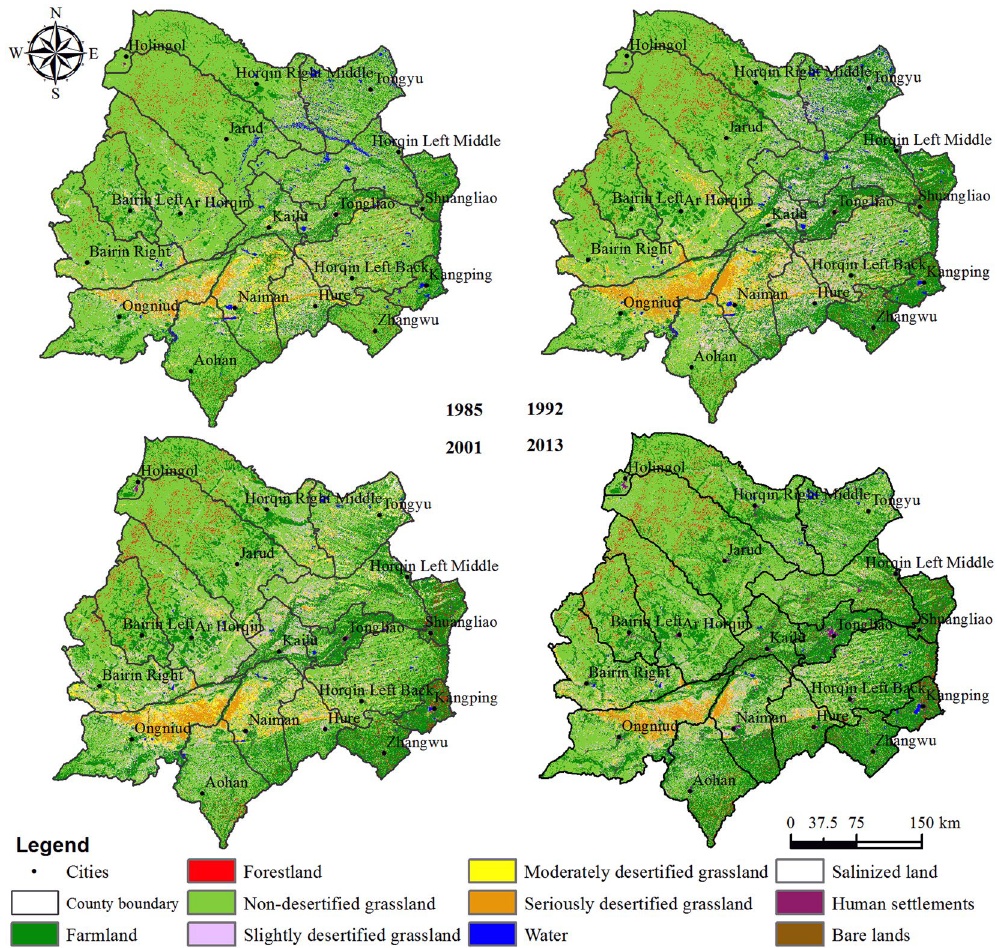
Figure 1. Status and spatial distribution of grassland desertification over four periods in HSL. The maps were generated by ArcGIS software (Version 10.0, ESRI, Redlands, CA, USA,